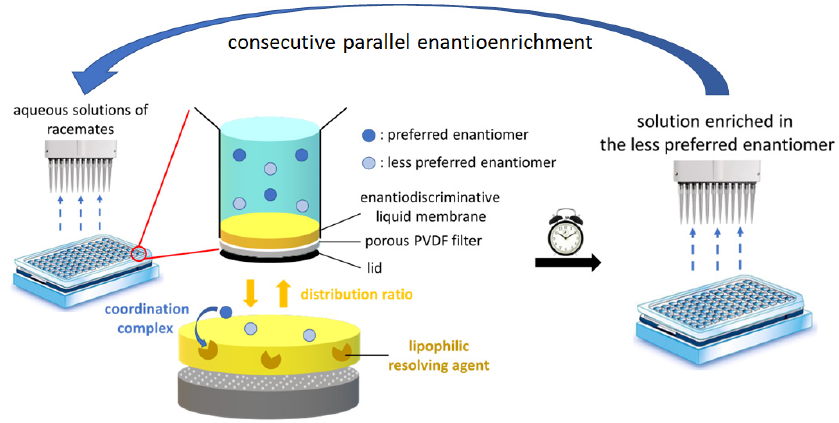
Figure 3. Concept of the novel high-throughput enantioenrichment method.